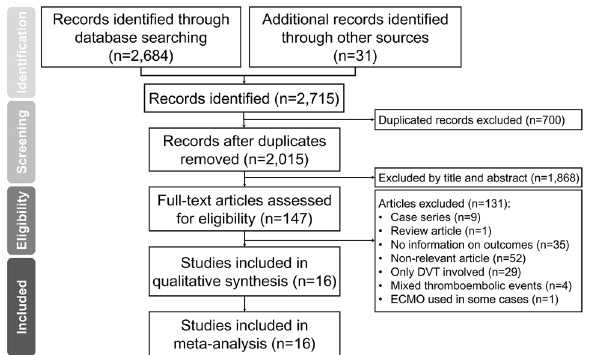
Figure 1. PRISMA flowchart for selecting eligible studies. DVT = deep vein thrombosis, ECMO = extracorporeal membrane